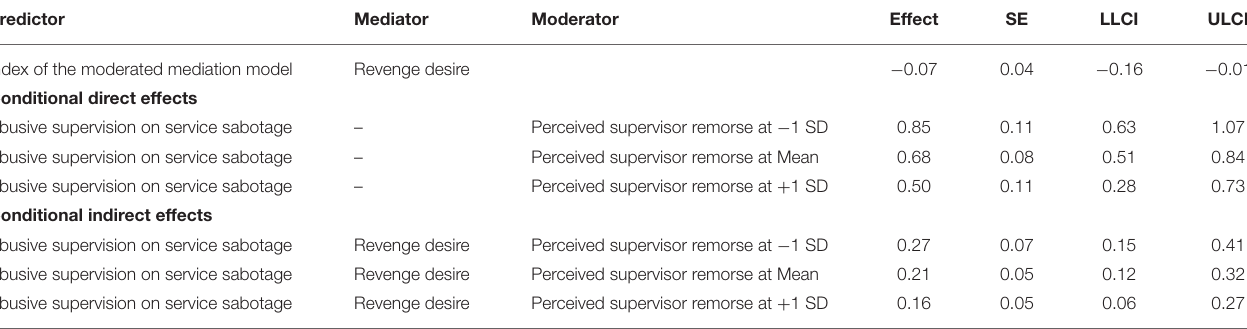
TABLE 4 | Results of conditional indirect effects and total conditional effects of abusive supervision on service sabotage at values of perceived supervisors’ remorse.